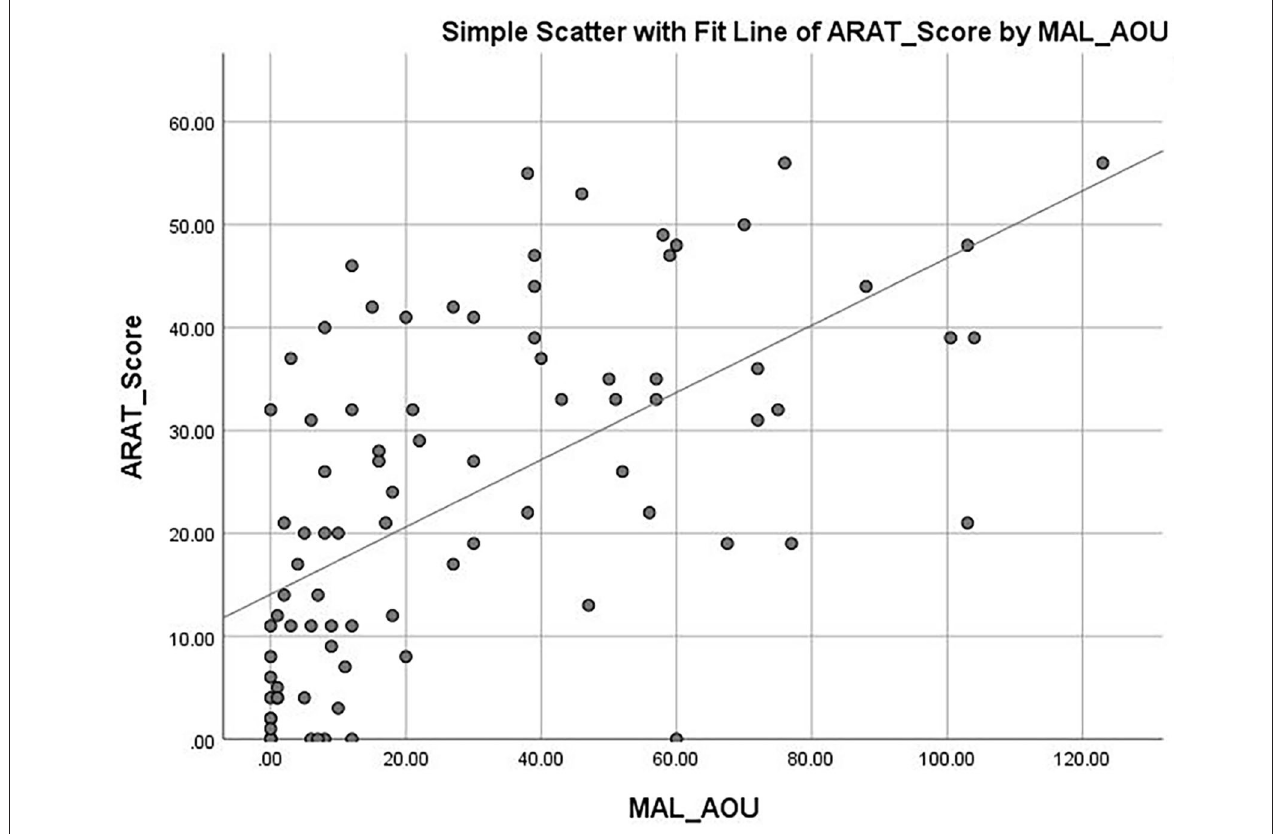
FIGURE 4 | The correlation between ARAT score and MAL-AOU score.